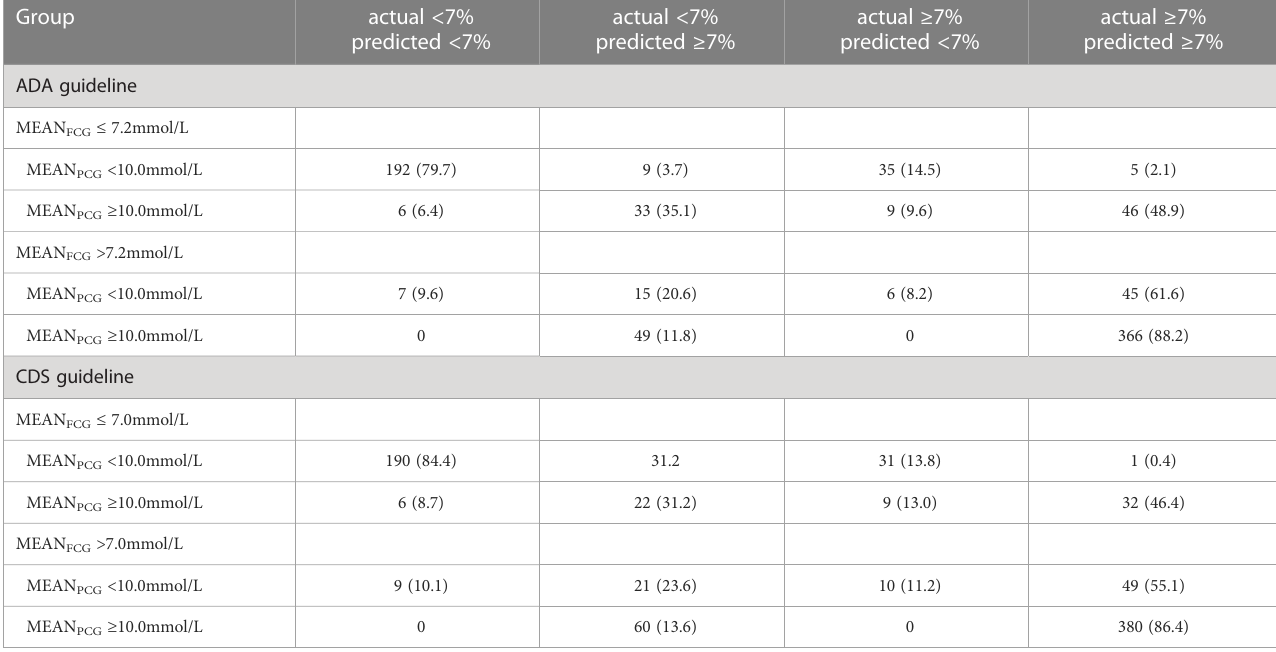
TABLE 3 Actual and predicted HbA1c grouped with FCG and PCG control targets.